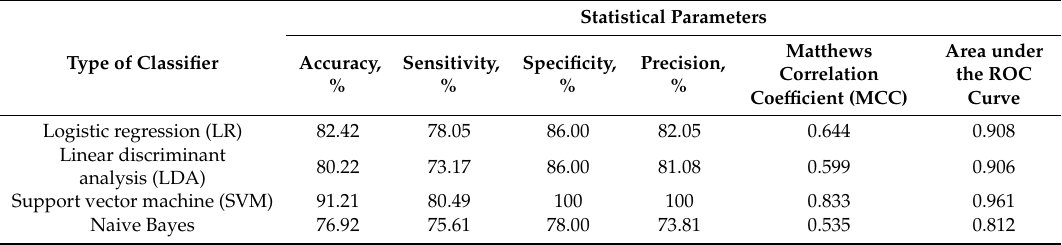
Table 3. Performance of classifiers by combining optical dermatoscopy and high-frequency ultrasonography (HFUS) imaging